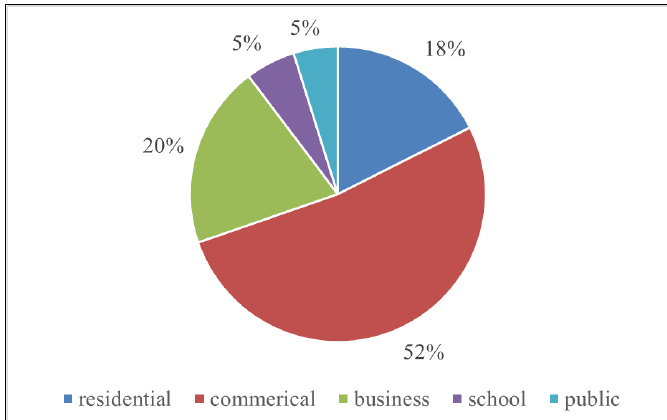
Figure 5. Parking lot types in Pocatello Old